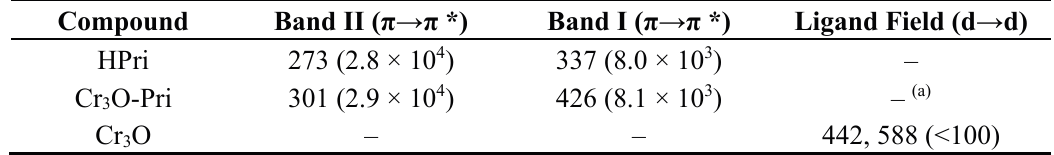
Table 2. Absorption maxima ( λ , nm) and molar absorptivities ( ε , M − 1 · cm − 1 ) of the main